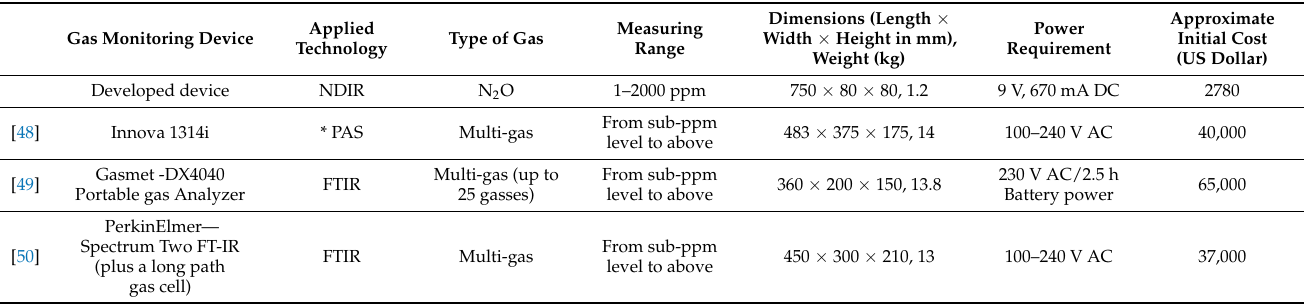
Table 2. Comparison in cost and other specifications of the developed device with commercially available gas analyzers. Gas Monitoring